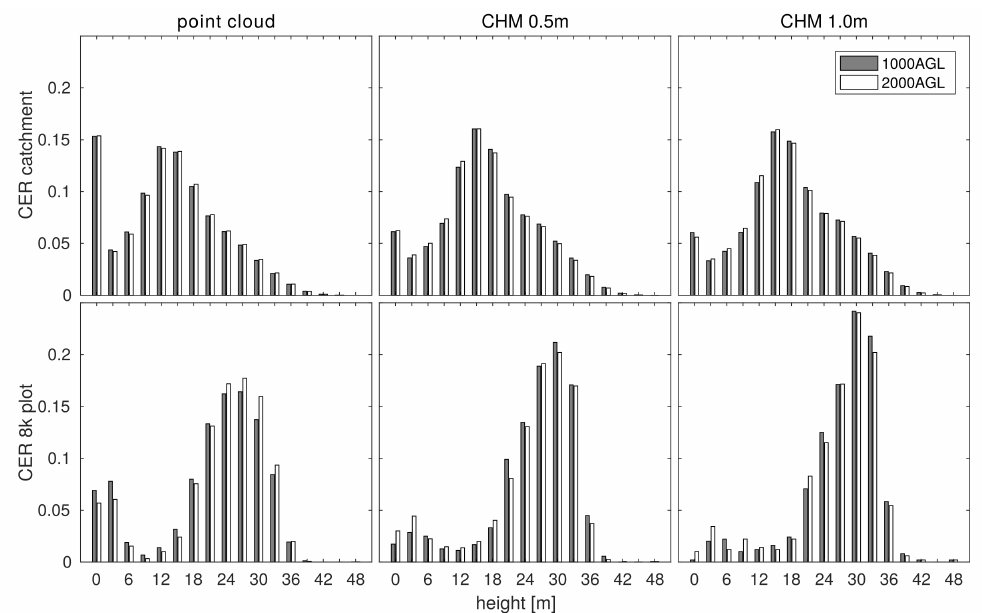
Figure 4. Histograms for height distributions of ALS input data acquired at point density of 8 pt/m 2 (1000 AGL) and 4 pt/m 2 (2000 AGL) at the level of the entire ˇCervík (CER) catchment ( top graphs ) and at the level of a single forest inventory plot (CER 8k) of size 500 m 2 ( bottom graphs ). Comparison of height distribution is shown for point cloud data ( left ) and for the canopy height model rasters with pixel sizes of 0.5 m ( middle ) and 1.0 m ( right